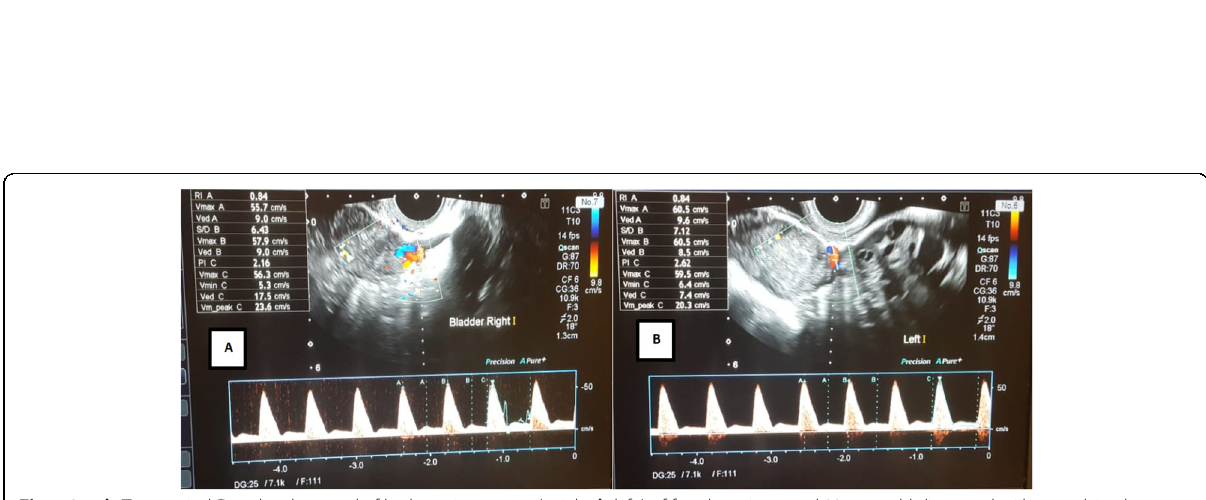
Fig. 10 a , b Transvaginal Doppler ultrasound of both uterine arteries ( a right, b left ) of female patient aged 33 years old diagnosed with unexplained infertility shows RI of right and left uterine arteries were 0.84 with mean RI 0.84, S/D ratios of right and left uterine arteries were 6.43 and 7.12 respectively with mean S/D ratio 6.77, and PI of right and left uterine arteries were 2.16 and 2.62 respectively with mean PI